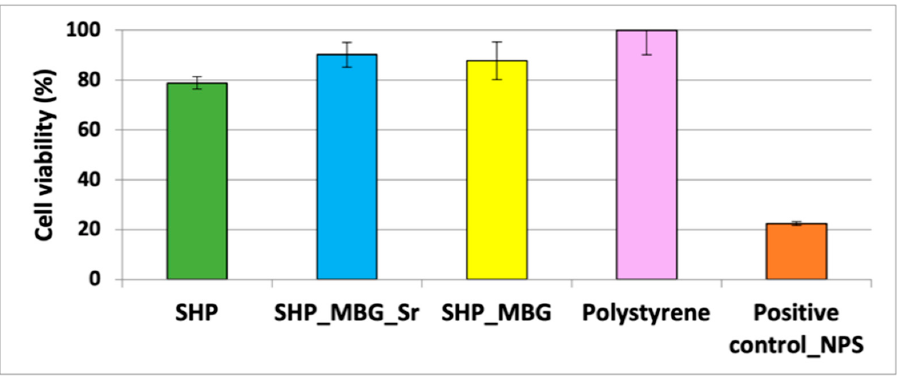
Figure 5. Quantification of cell viability through an MTT assay for SHP alone, SHP_MBG and SHP_MBG_Sr compared with polystyrene (negative control) and a positive control (polystyrene with 0.08 g mL − 1 of NPS).